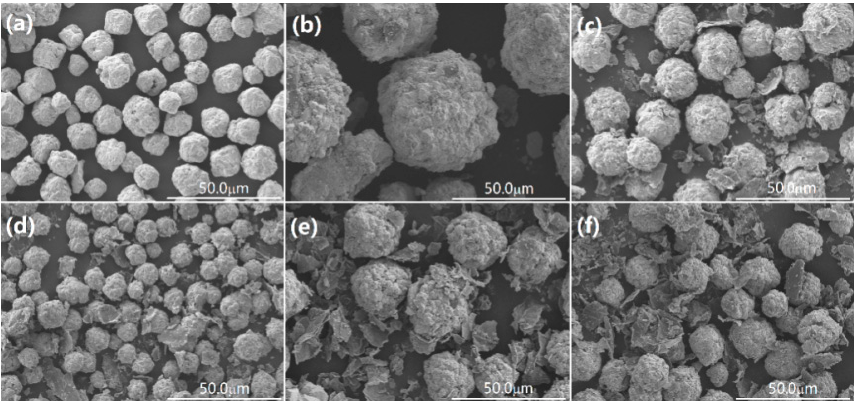
Figure 2. Scanning electron microscope (SEM) images of ( a ) BFO; ( b ) BGO10; ( c ) BGO30; ( d ) BGO60; ( e ) BGO 100; ( f ) BGO150.